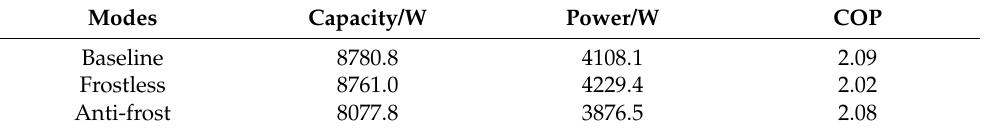
Table 4. Time-averaged energy outputs of the ASHP during heating supply for all